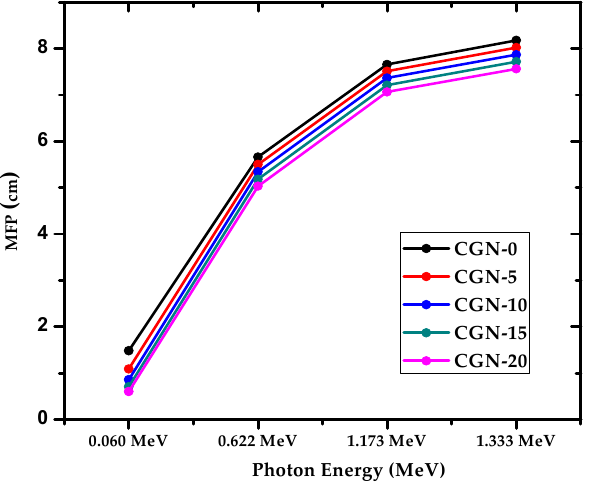
Figure 10. The HVLs and the densities of prepared CGN-samples at different energies. ( a ) at 0.060 MeV, ( b ) 0.622 MeV, ( c ) 1.173 MeV and ( d ) 1.333 MeV.